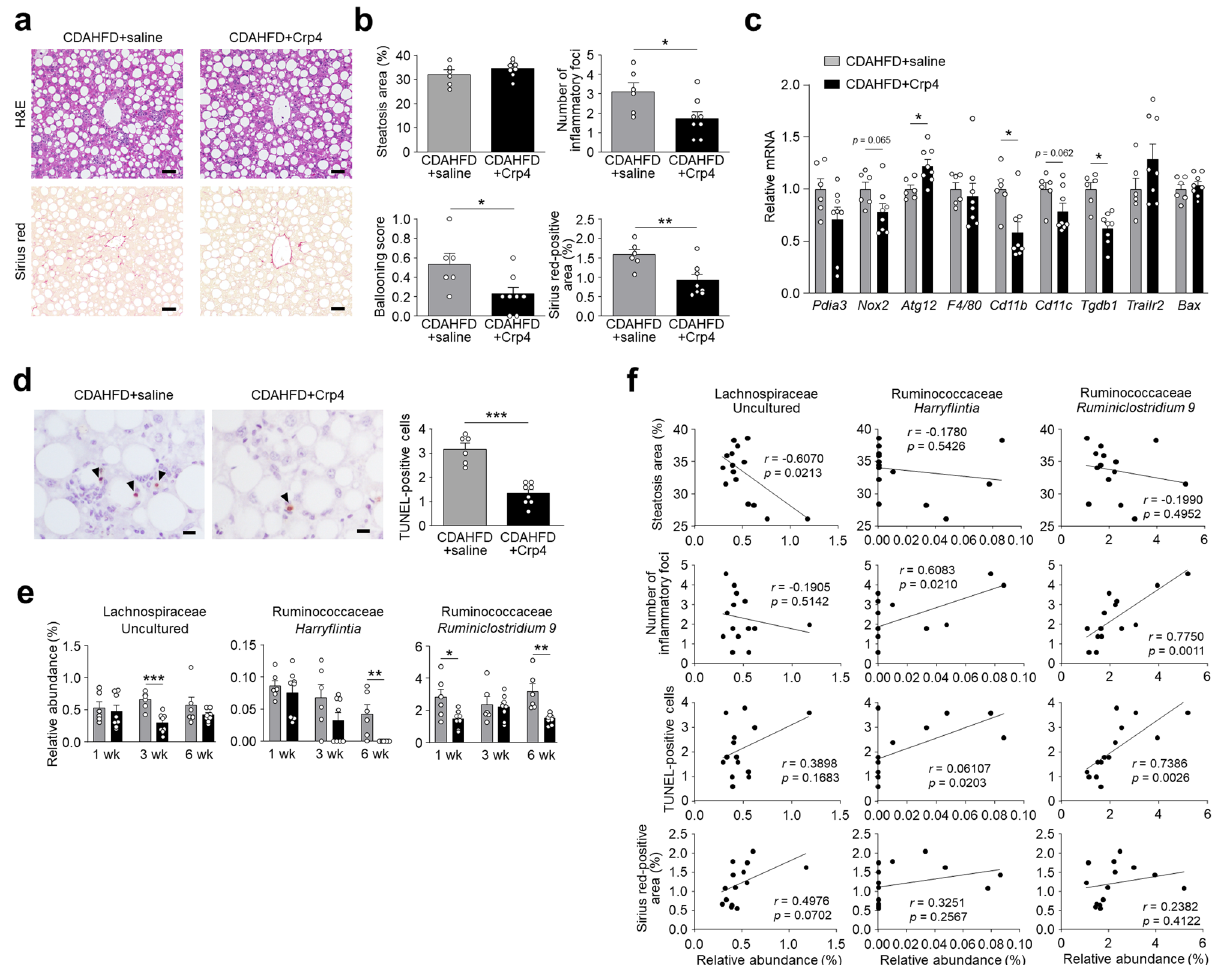
Figure 6. Oral administration of Crp4 increases autophagy related gene expression, suppresses dysbiosis, and ameliorates liver fibrosis. Six-week-old C57BL/6 J mice were fed CDAHFD to induce NASH and orally administered with Crp4 at a dose of 110 µg or saline twice daily for 6 wk. ( a ) Representative images of H&E- and Sirius red-stained liver sections. Scale bars: 50 µm. ( b ) Quantification of steatosis area, lobular inflammation, hepatocellular ballooning, and Sirius red-positive area. The degree of lobular inflammation was evaluated by counting the number of inflammatory foci. ( c ) Hepatic mRNA expression of ER stress, oxidative stress, autophagy, inflammation, and apoptosis marker genes. ( d ) Representative images of TUNEL staining of liver sections and quantification of TUNEL-positive cells. Scale bars: 10 µm. ( e ) Relative abundance of individual genera that were significantly recovered in CDAHFD + Crp4 group from CDAHFD group of 28 genera shown in Fig. 4d. ( f ) Correlation analysis between relative abundance of individual genera and NASH pathology. Data are shown as mean ± SEM for n = 6–8 per group. * P < 0.05, ** P < 0.01 and *** P < 0.001, by unpaired two-tailed Student’s t test ( b , c , d , e ) and Pearson correlation test ( f